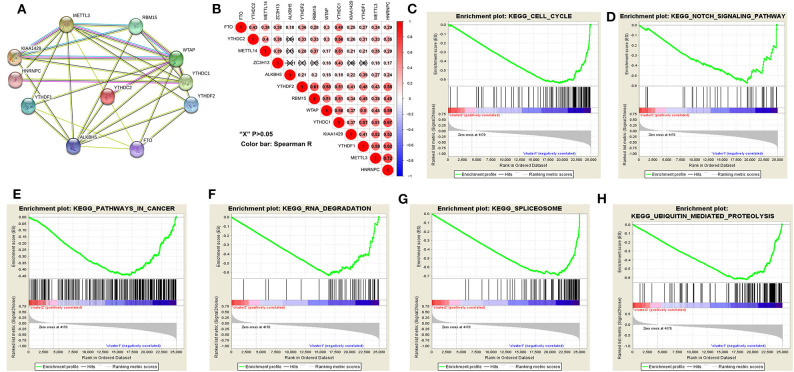
Differential clinicopathological features and overall survival of HCC in the cluster1/2 subgroups. (A) Consensus clustering cumulative distribution function (CDF) for k = 2–10. (B) Relative change in area under CDF curve for k = 2–10. (C) Principal component analysis of the total RNA expression profile in the TGGA dataset. (D) Kaplan–Meier overall survival (OS) curves for HCC patients according to cluster1/2.